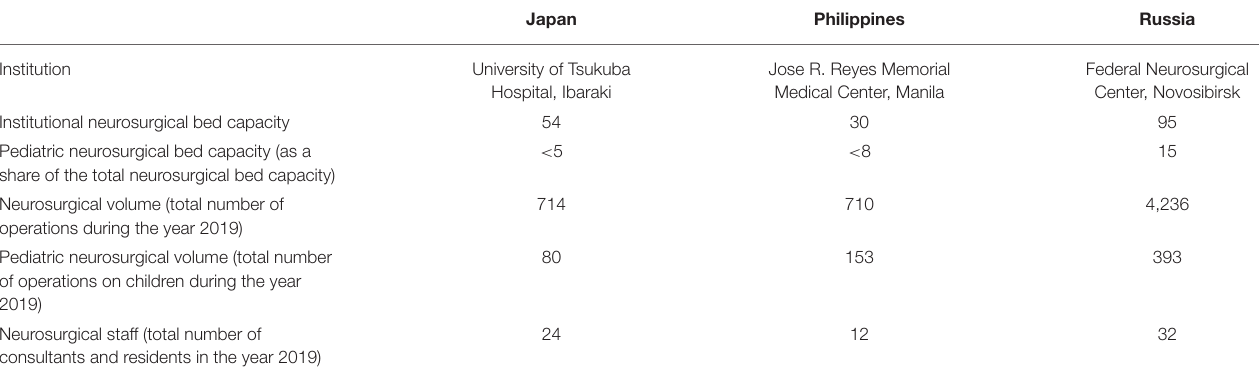
TABLE 6 | Institution-level data in terms of relevant metrics of Global Surgery